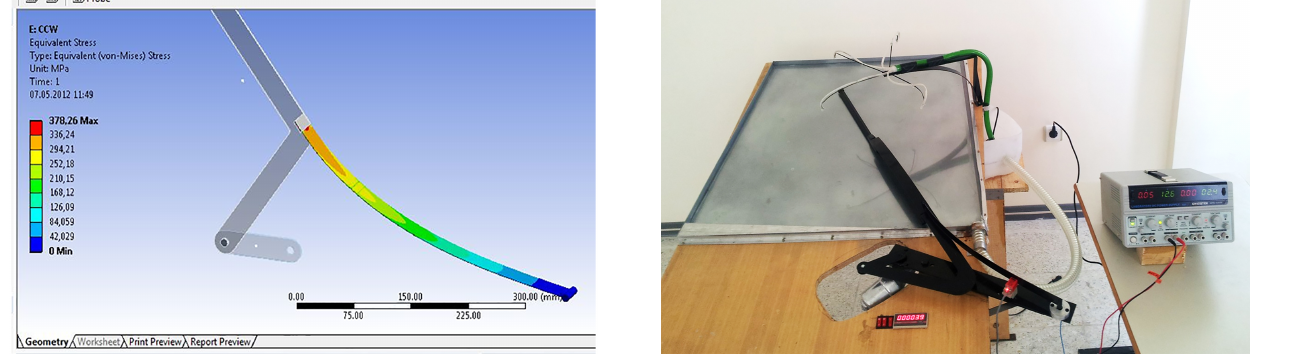
Figure 11. FEA of the compliant segment. Figure 12. Prototype and test